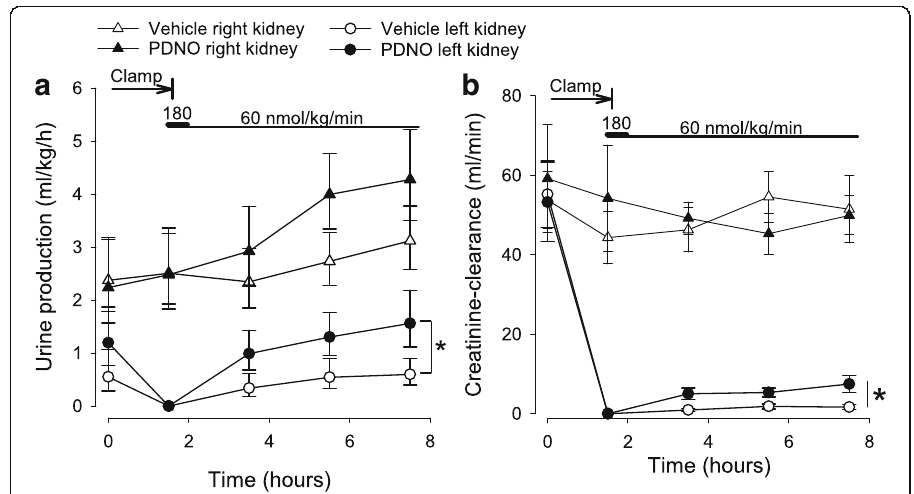
Fig. 2 Urine output ( a ) and creatinine clearance ( b ) in 16 anesthetized sheep subjected to left renal ischemia and reperfusion. Renal ischemia was caused by clamping of the renal artery for 90 min. Fifteen minutes prior to the release of the clamp, intravenous infusions with either the organic mononitrites of 1,2-propanediol (PDNO, n =8) or vehicle (1,2-propanediol + inorganic nitrite, n =8) were commenced. The infusions continued for 6 h. Data are expressed as mean and SEM. Significant ( p <0.05) differences in response to PDNO compared to vehicle is indicated by an